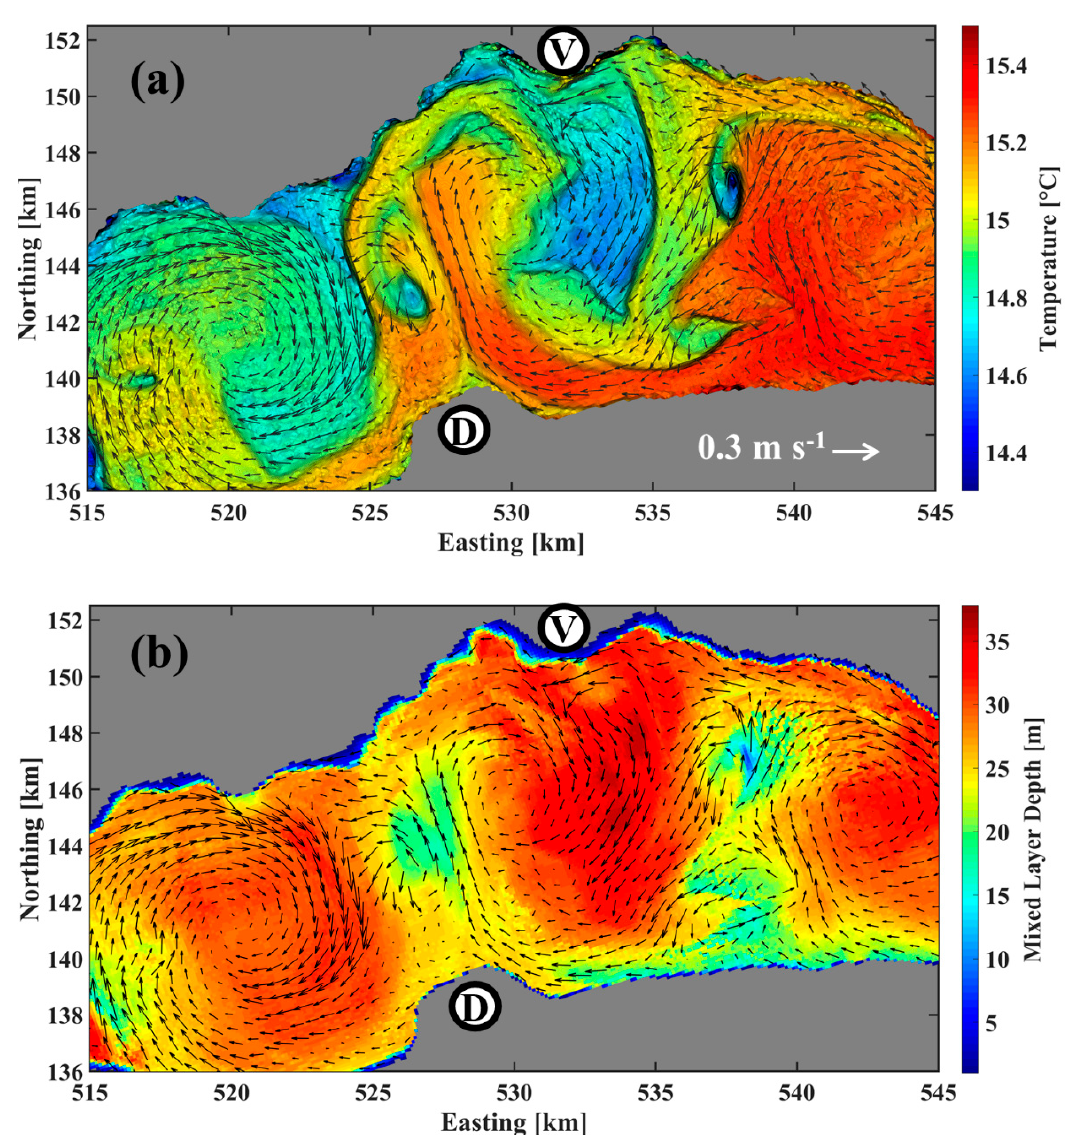
Figure 8. ( a ) Simulated temperature (colors; colorbar legend: temperature range) and current (arrows; reference arrow in legend) at 0.3 m depth. ( b ) Simulated Mixed Layer Depth (colorbar legend: depth range) from a high-resolution, 3D numerical simulation for 26 October 2021 at 06:00 UTC. V and D are the reference points marked in Figure 1.